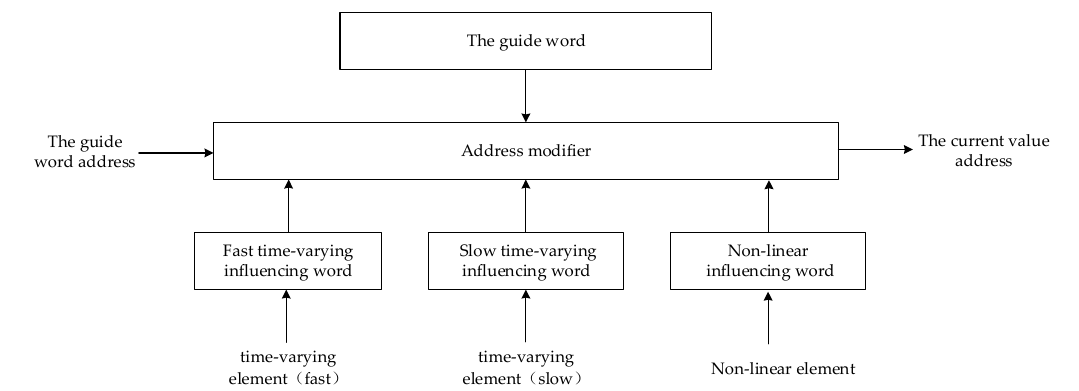
Figure 5. The mapping circuit converting the guide word address to the current value address.